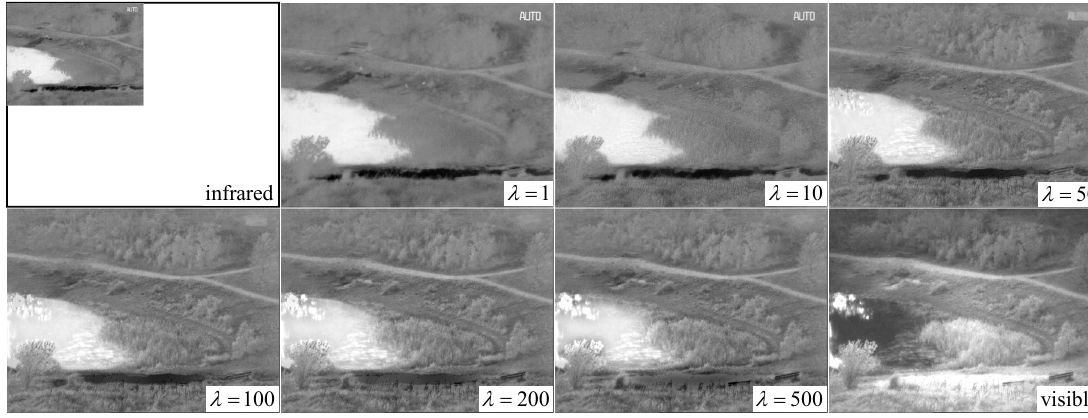
Figure 5. Fusion results of our DRTV on lake when parameter λ